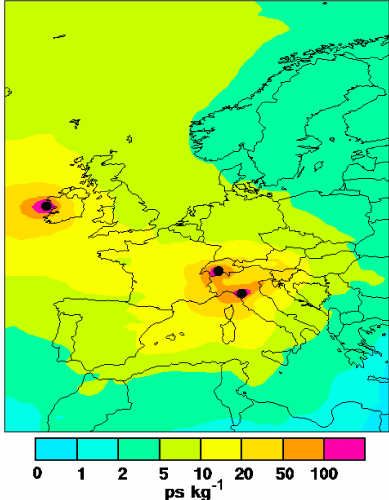
Figure 1. Footprint emission sensitivity in picoseconds per kilo- gram (pskg − 1 ) obtained from FLEXPART. 20-day backward cal- culations averaged over all model calculations over 2 years (Jan- uary 2008–December 2009). Measurement sites are marked with black